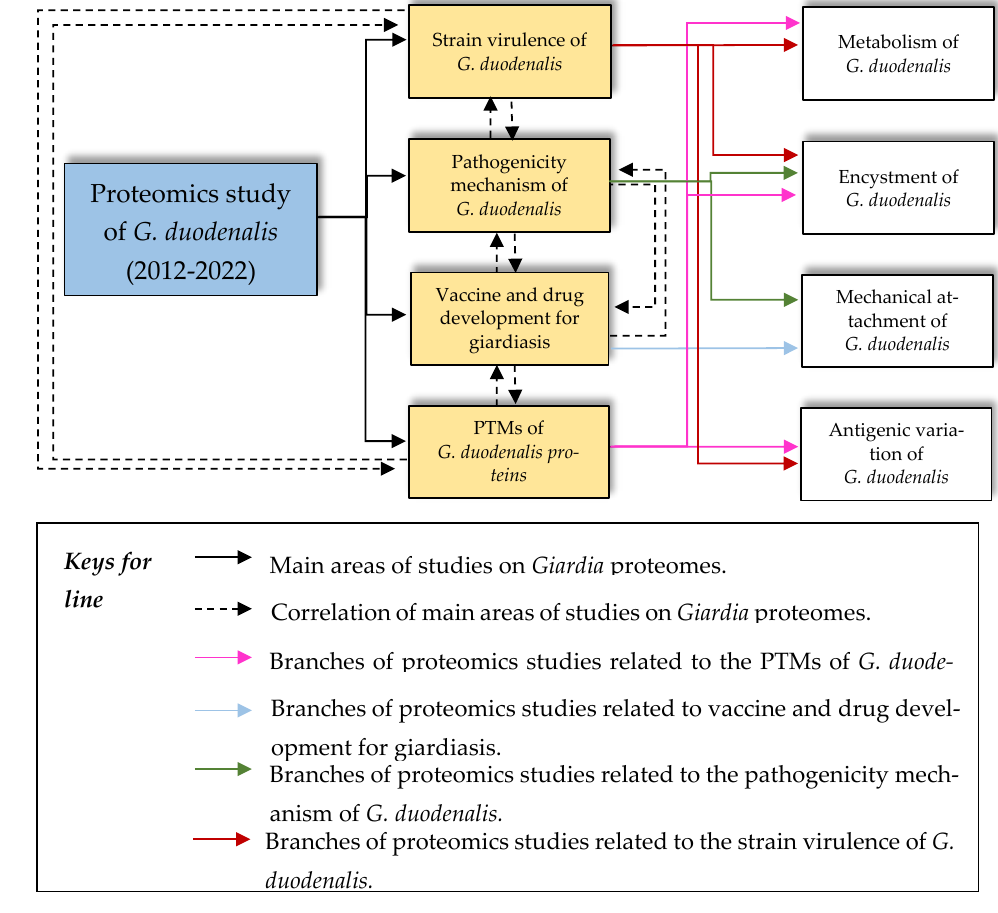
Figure 2. The relationships between areas of studies in the current proteomics studies on G. duodenalis from 2012 to 2022. The past decade of proteomics studies on G. duodenalis were mainly focused on determining the areas of study (as described in the gold boxes) to enhance the basic understanding of Giardia cellular behaviours, life cycle, and structure (as highlighted in the white boxes). Table 1. Summary of proteomics-based analyses of G. duodenalis from 2012 to 2022.